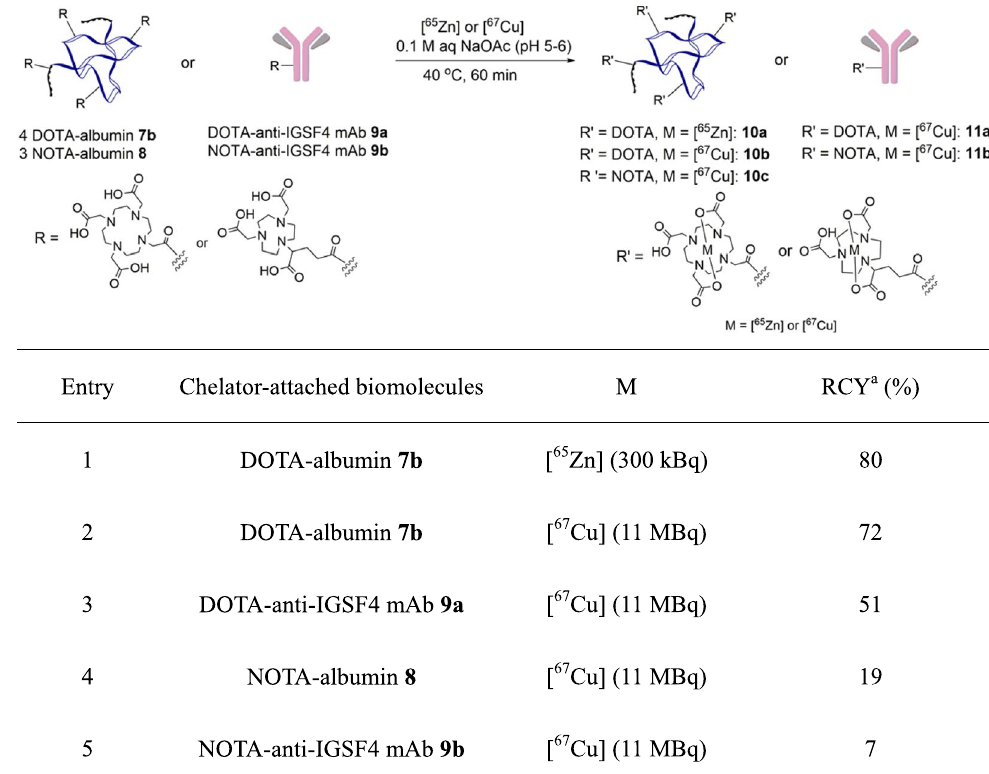
Figure 5. Radiolabelings of DOTA or NOTA-attached albumins and anti-IGSF4 antibody. a Radiochemical yield. Specific activity of 67 Cu and 65 Zn was 110 MBq μ g − 1 and 125 MBq μ g − 1 ,